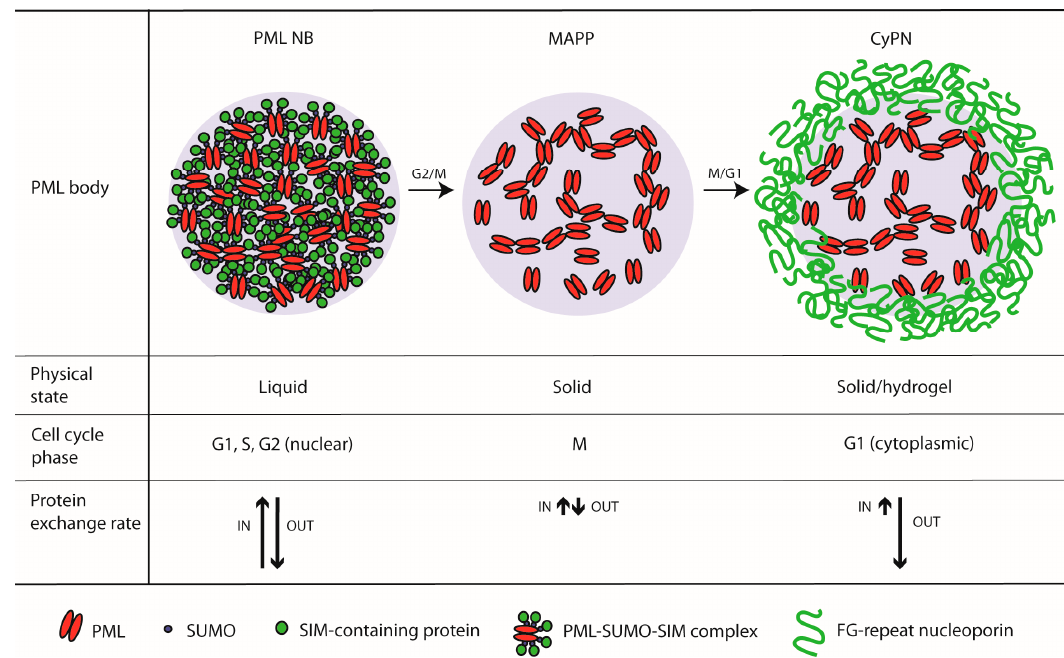
Figure 2. PML body biophysics at different stages of the cell cycle.